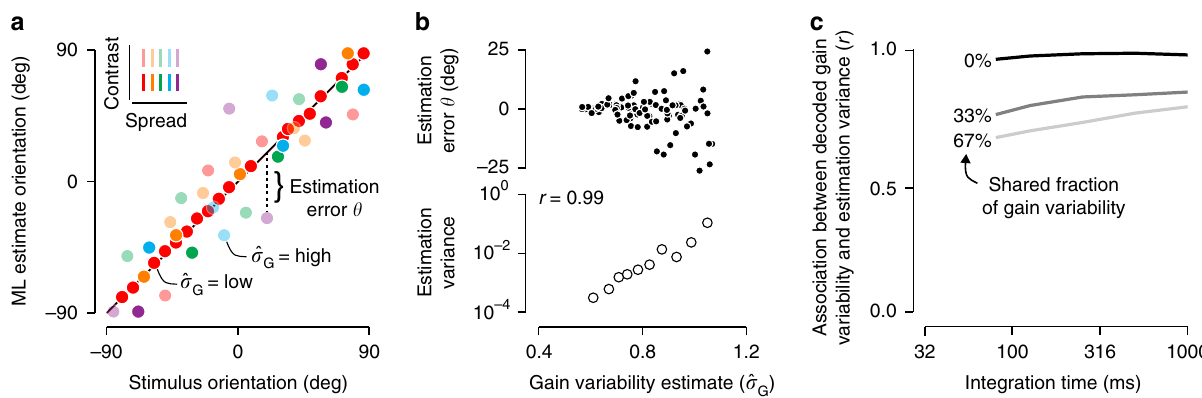
Fig. 8 Quantitative performance of uncertainty decoding. a Estimated orientation plotted against stimulus orientation for an example population ( n = 250 heterogeneous units, integration time = 1000 ms, shared gain fl uctuations = 0%). Stimuli varied in orientation, contrast, and spread. b Top: orientation estimation error plotted against gain variability estimates. Each symbol represents a single trial. Only a fraction of the trials is shown for clarity. Bottom: the circular variance of the orientation estimation error is plotted against gain variability estimates. Each symbol summarizes 100 trials; trials were grouped based on their gain variability estimates (percentile 0 – 10, 11 – 20, etc.). We measure the strength of the association with Spearman's rank correlation coef fi cient ( r ). c Effects of integration time and shared gain fl uctuations on uncertainty